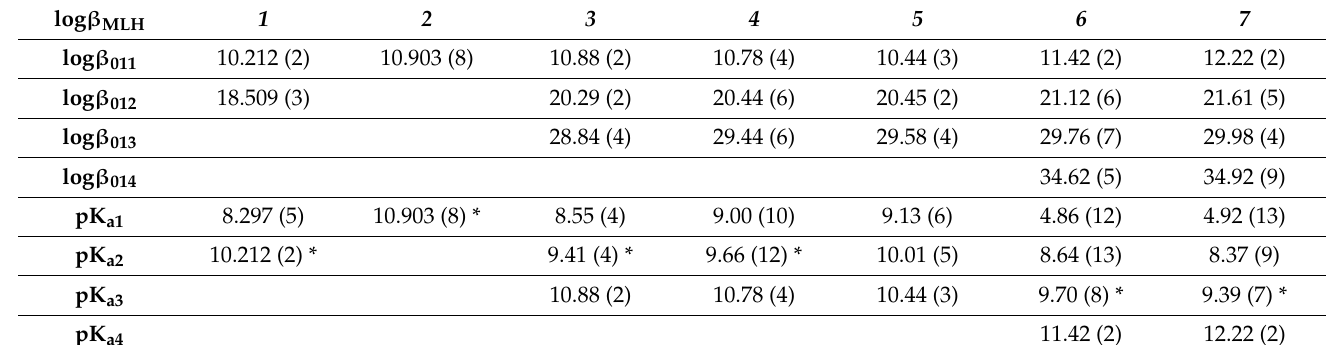
Table 2. Overall protonation constants calculated from spectrophotometric data at 298 K using HypSpec software [34]; pK a values were calculated from log β values as follows: